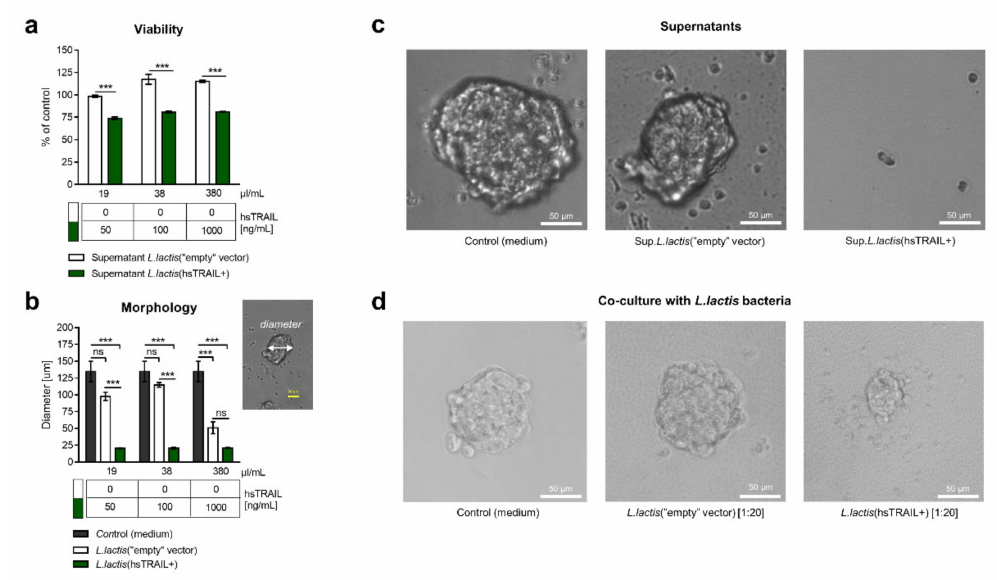
Figure 2. Activity of hsTRAIL against HCT116-derived tumorspheres: ( a ) HCT116-spheres were cultured for six days with increasing concentrations of hsTRAIL in supernatant from the broth culture of L. lactis (hsTRAIL+) bacteria. Corresponding volumes of supernatant from the broth culture of L. lactis (“empty” vector) bacteria was used as a negative control. The tumorsphere viability was assessed using MTS assay and shown as % of viable HCT116-spheres incubated in a standard culture medium ( y -axis). Legend: x -axis—volume of the specific supernatant added/mL of a total volume of a sample; Table below—concentration of hsTRAIL [ng/mL] in a specified volume of supernatant. The bars indicate the mean value ± SEM from three independent experiments performed ( n = 3). Statistical significance was calculated using two-way ANOVA test, with Tukey’s multiple comparisons post-hoc test, *** p < 0.001; ( b ) Morphology of HCT116-spheres after six days of treatment was assessed by measuring their diameter [ µ m]. The measurements were performed for optically the largest spheres using paint.net (version 4.1.6), as indicated in the attached photo. Legend: x -axis—volume of the specific supernatant added/mL of a total volume of a sample; Table below—concentration of hsTRAIL [ng/mL] in a specified volume of supernatant. The bars indicate the mean value ± SEM, from four independent experiments performed ( n = 4). Statistical significance was calculated using two-way ANOVA test, with Tukey’s multiple comparisons post-hoc test. *** p < 0.001; ( c ) Representative photos of HCT116-spheres cultured for six days in the presence of a standard culture medium, supernatant from broth culture of L. lactis (hsTRAIL+) or L. lactis (“empty” vector). Brightfield microscopy, scale bar: 50 µ m; ( d ) Representative photos of matured HCT116-spheres co-cultured for 48 h in the presence of standard culture medium, L. lactis (hsTRAIL+) bacteria in a dilution 1/20 of the broth culture or L. lactis (“empty” vector) broth culture at the same dilution. Brightfield microscopy, scale bar: 50 µ